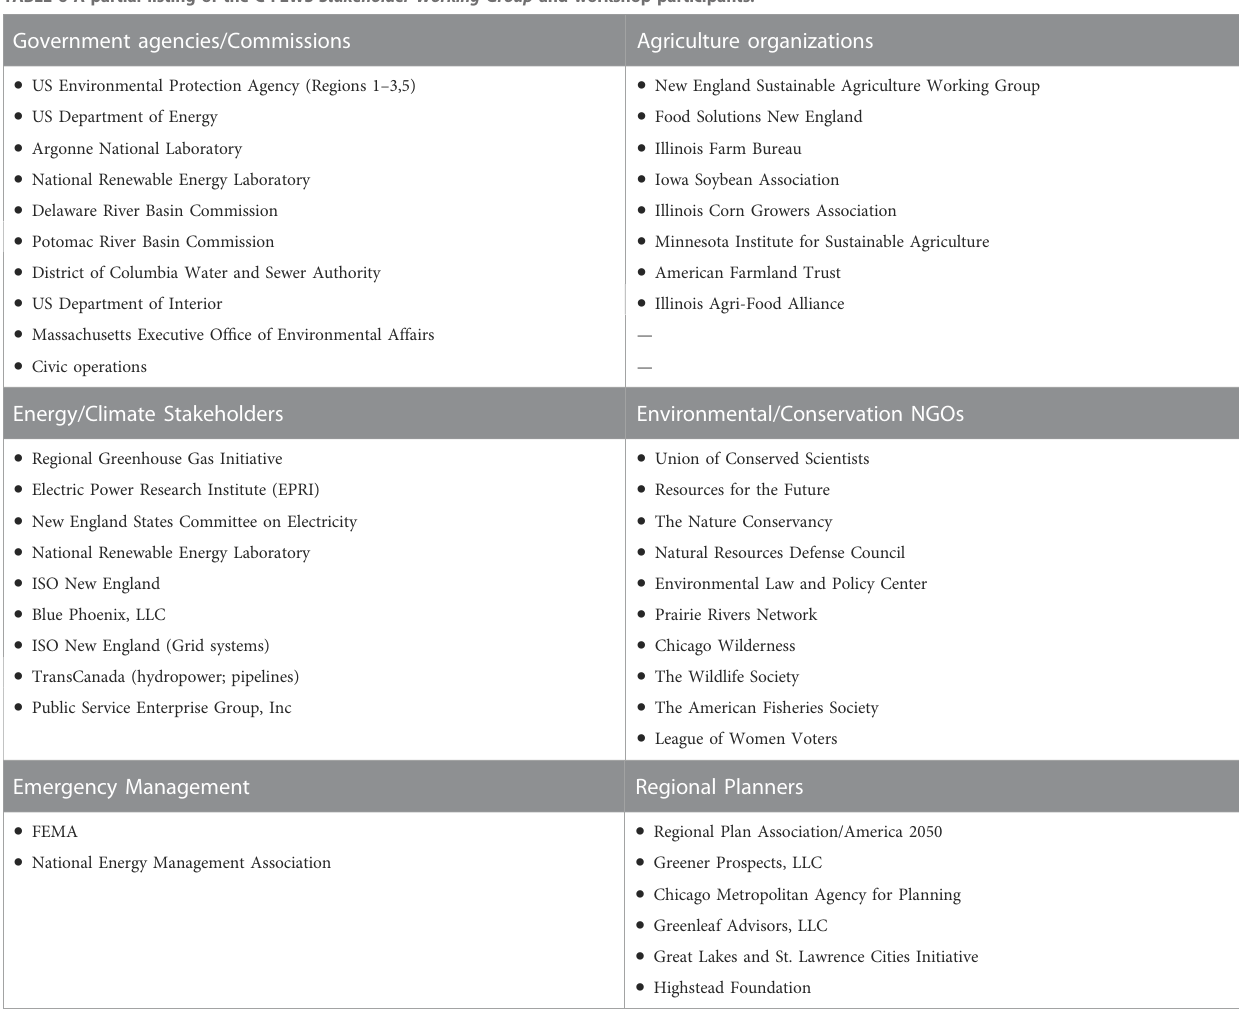
TABLE 6 A partial listing of the C-FEWS Stakeholder Working Group and workshop